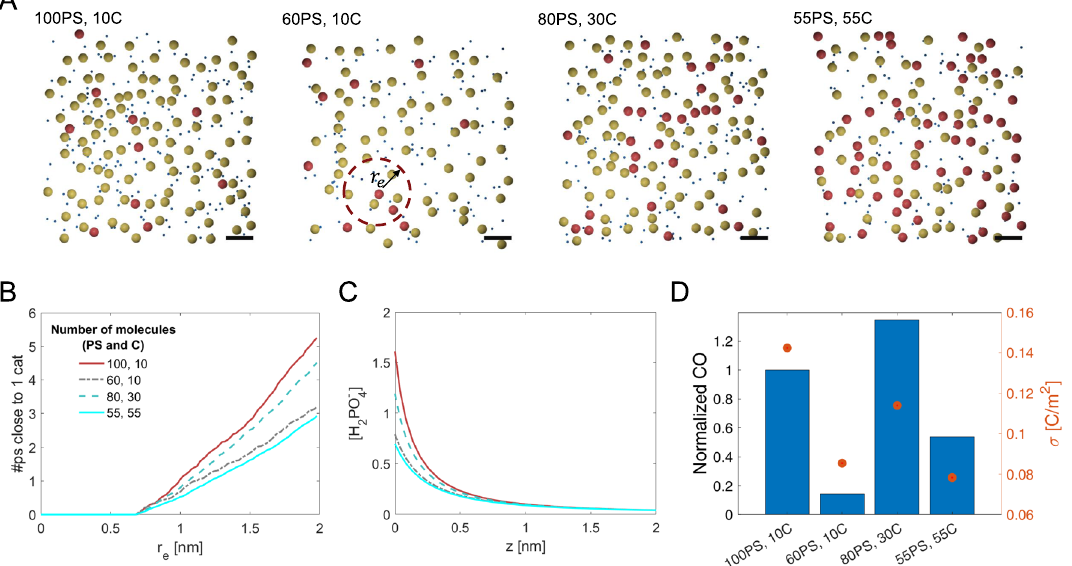
Fig. 2 Surface concentration of the photoactive molecules and its influence on the CO production. A One of the resulting microstates from the Metropolis Monte Carlo simulations for each of the mixtures analyzed; the PS, their counterions and the C are shown as yellow, blue and red spheres, respectively. The scale (black) bar is 2 nm, and r e is the radial distance from a generic catalyst C. B Dependence of the average number of photosensitizers close to a single catalyst for the different mixtures reported in Table 3. The distance is calculated between the two geometric centers of a spherical representation for the photosensitizer and the catalyst. C Concentration profile (Gouy–Chapman dif- fuse layer) for the H 2 PO − 4 at the CO 2 reduction side. D CO production, normalized to the 10:1 case ( d n ∕d t = 3.599 × 10 − 7 mol m − 2 s − 1 with = c 0 = 10 mM, of the electron relays c 0 initial concentration of the phosphate buffer c 0 H = 2.5 mM and external CO 2 pres- = c 0 HPO 2 − 4 Q Q − 2 PO − 4 = 1 atm). The orange circles correspond to the surface charge density of the sure p CO 2